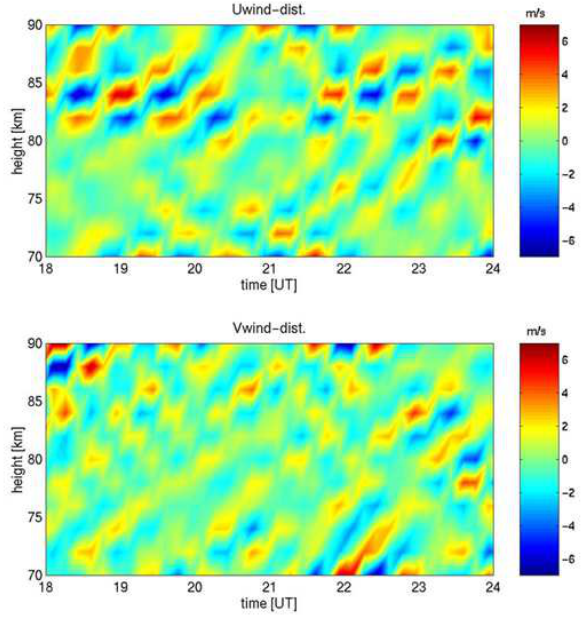
Fig. 9. Height-time distributions of zonal and meridional wind dis- turbances by Andenes MF radar measurements on 10 August 2000. Band-pass digital filtering both in the vertical direction and in time was applied to the original wind